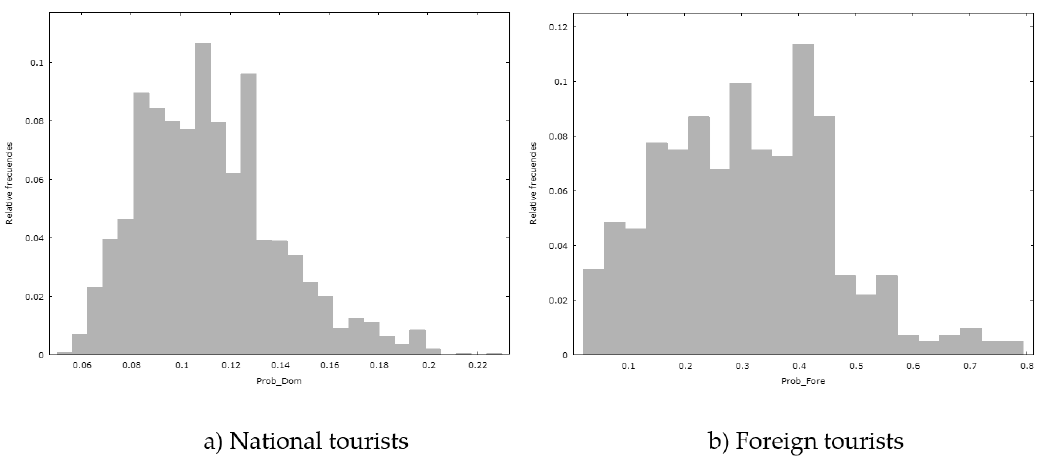
Figure 1. Frequency histogram of the estimated probabilities of going birdwatching: ( a ) Histogram for national tourists; ( b ) Histogram for foreign tourists. Table 5. T-tests of equality of estimated probabilities of going birdwatching for national tourists and foreign tourists.